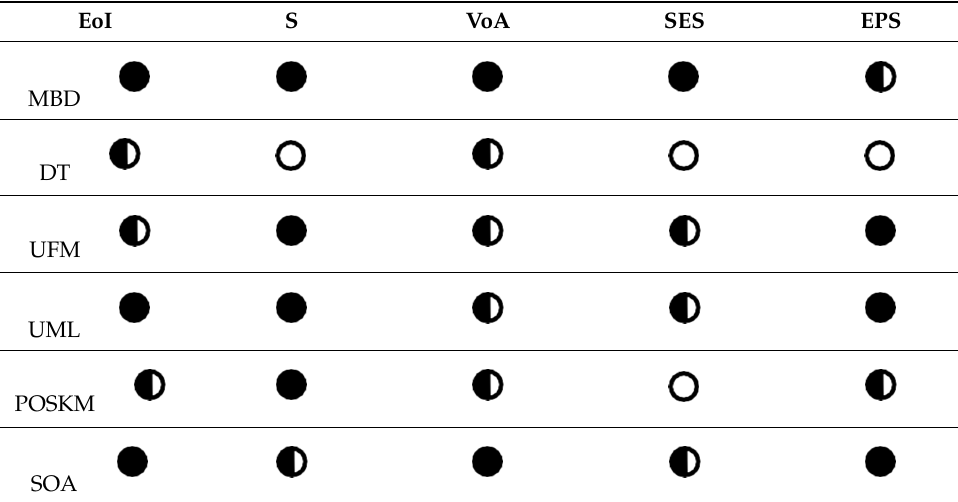
Table 4. Extent of Success of Frameworks.